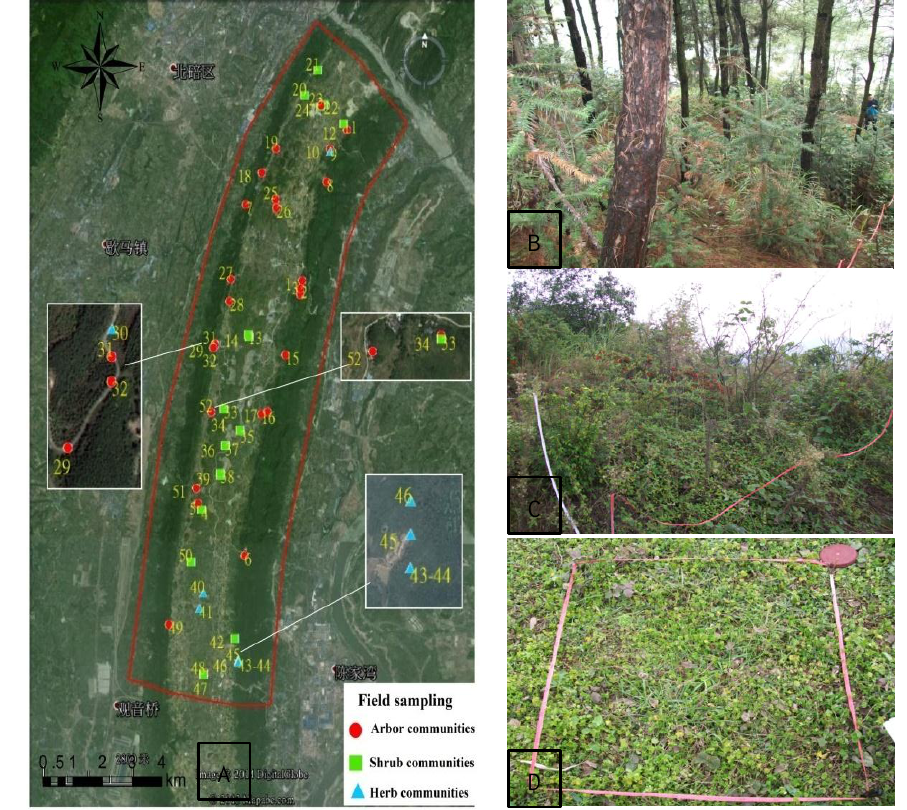
Figure 7. Distribution of plots in Zhongliang Mountain.